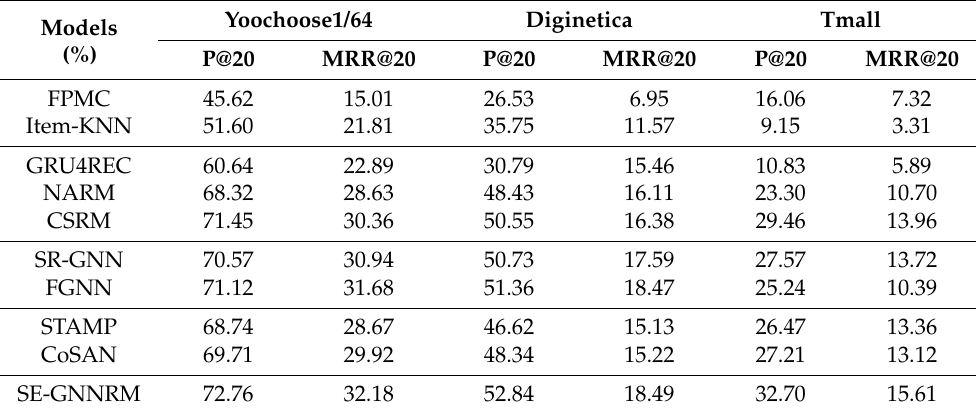
Table 2. Comparative experimental